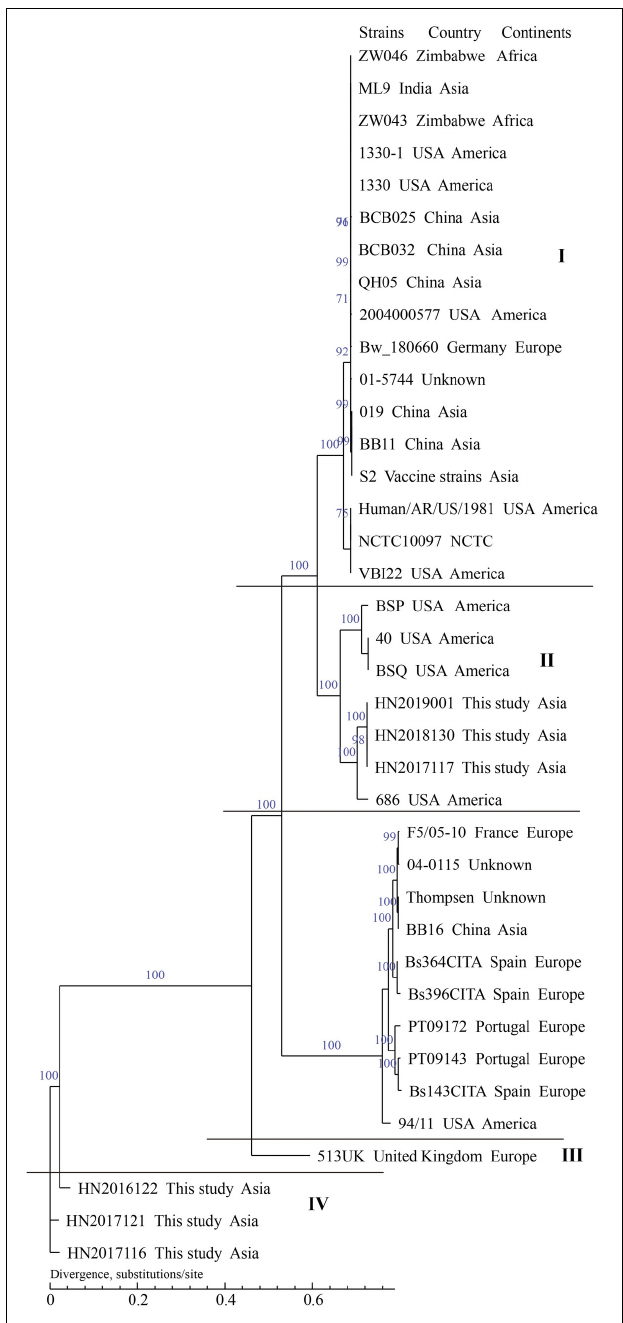
FIGURE 9 | Phylogenetic trees of Brucella suis using SNPs from whole genomes. The dendrograms were generated using maximum likelihood with 1000 bootstrap